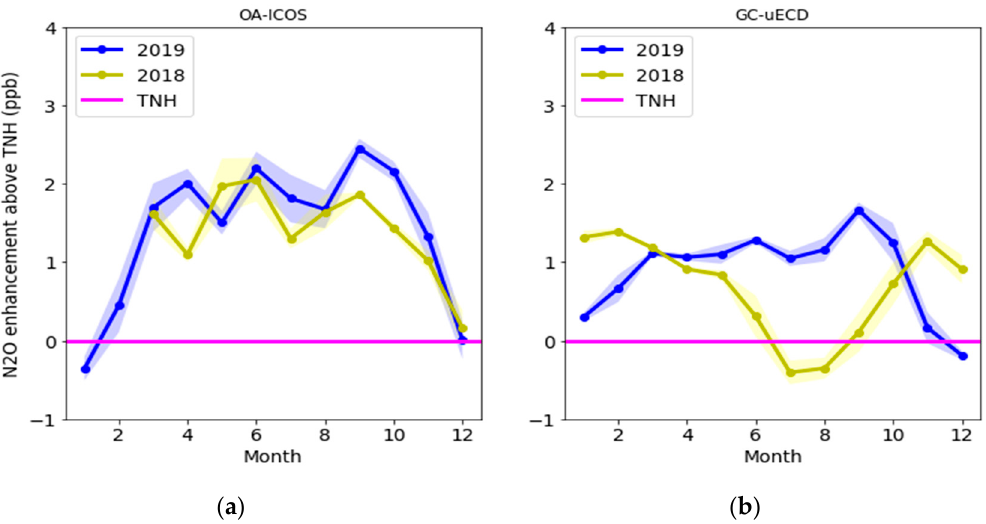
Figure 4. The JGS N 2 O enhancement values (exN 2 O) observed by OA-ICOS ( a ) and the GC- μ ECD ( b ) in 2018 (yellow line) and 2019 (blue line), respectively. The yellow line represents the atmospheric N 2 O observed by the GC- µ ECD and blue line by OA-ICOS. The magenta line is the zonal mean atmospheric N 2 O for 17.5 ◦ N to 53.1 ◦ N obtained from the National Oceanic and Atmospheric Administration (NOAA). The uncertainty bands for the GC- µ ECD and OA-ICOS were standard deviations of the monthly mean. TNH: temperate Northern Hemisphere.